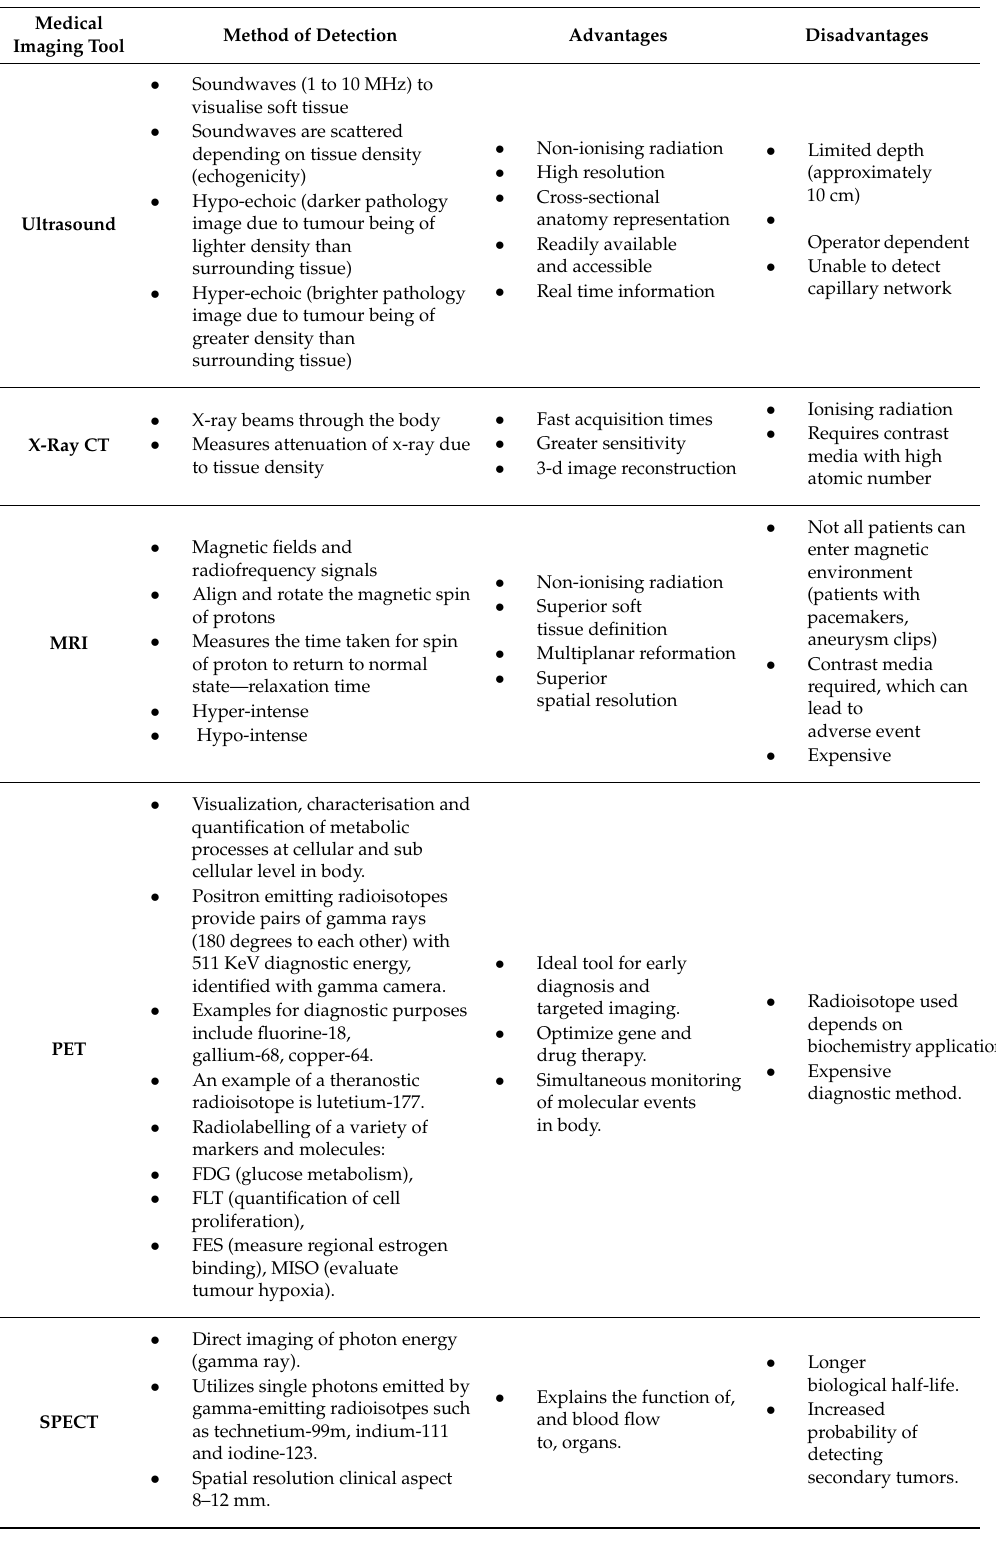
Table 1. The different methods of malignant tumour cell detection by current medical imaging modalities and its advantages and disadvantages. Source adapted from